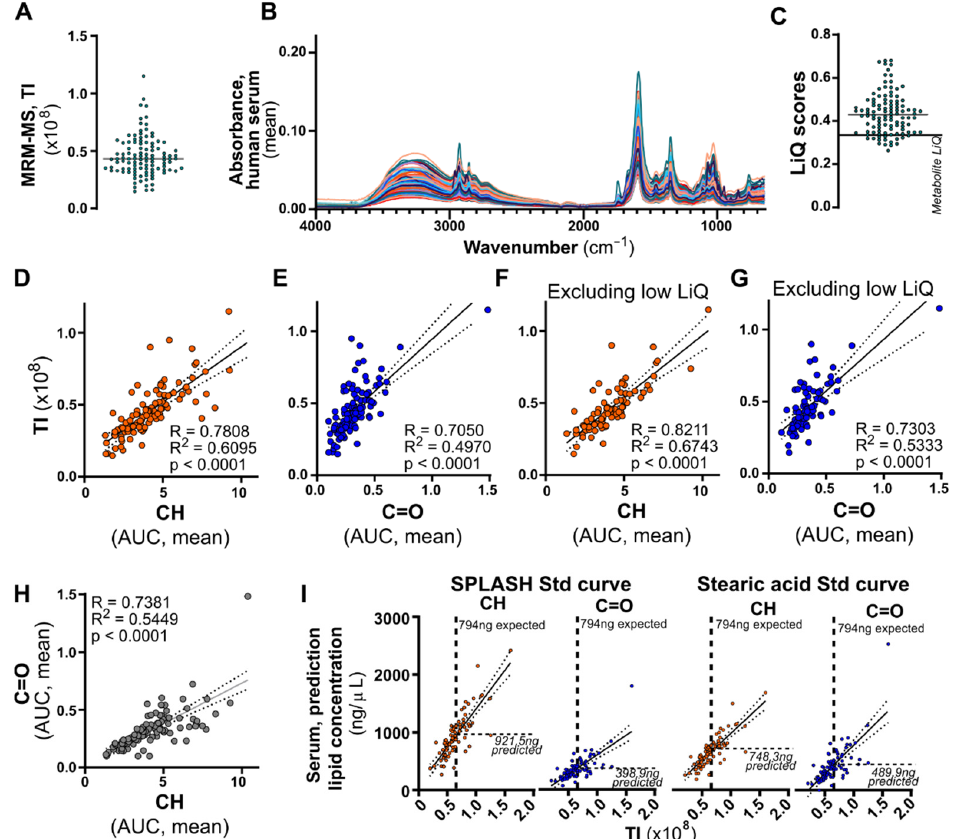
Figure 4. Comparison of ATR-FTIR quantification and mass spectrometry, and quality control analysis of human plasma lipidomics samples. Lipids were extracted from 107 human plasma samples using the BuMe method and analyzed using ATR-FTIR spectroscopy and multiple-reaction monitoring mass spectrometry (MRM-MS). ( A ) Jitter plot of all total intensities (TI) measured by mass spectrometry for each sample. ( B ) Absorbance spectra acquired by ATR-FTIR spectroscopy for 107 human plasma lipidomics samples. Technical replicates were averaged. ( C ) Lipid quality (LiQ) score for each plasma sample. The LiQ score for pure metabolite samples (LiQ = 0.351) is shown as a thick black line. ( D – G ) The CH and C=O regions were measured by AUC and compared to MS by simple linear regression (R 2 and p values) and Pearson correlation (R values). ( D,E ) Comparison for all 107 human plasma lipidomics samples. ( F,G ) Comparison for 82 human plasma lipid quantification after removal of low-LiQ-scoring samples. ( H ) Linear relationship between the AUC of the CH and C=O regions detected by FTIR spectrometry of human plasma lipid samples. ( I ) Absolute quantification of human plasma lipid samples using SPLASH Lipidomics or stearic acid standard curves. The CH (orange) and C=O (blue) regions were measured for both standards and compared to TI by linear regression analysis. Quantification of a 794 ng/µL lipid control was also carried out via MS and compared to the FTIR regression equation to calculate predicted absolute quantities by different standards and regions.